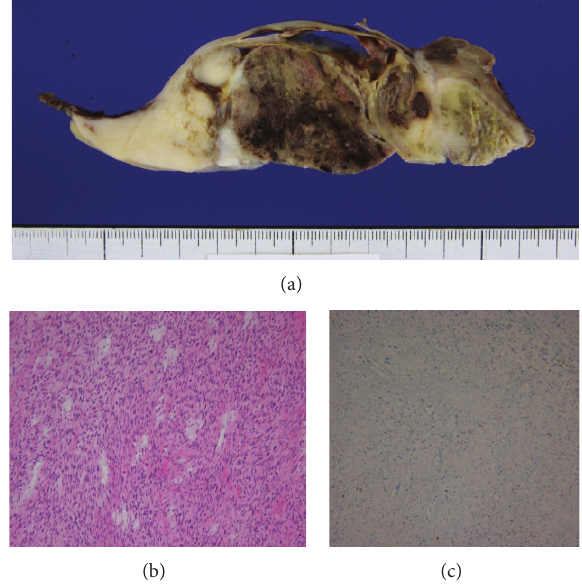
Figure 2: Macroscopic appearance of the cut surface of the resected tumor shows some hemorrhage and necrosis in the center. It was 22 × 17 × 9 cm in size (a). Microscopically, the tumor is composed of homogenous spindle cells (hematoxylin and eosin, ×100 ) (b). Immunohistochemical stains showing positivity to neuron-specific enolase (c), consistent with